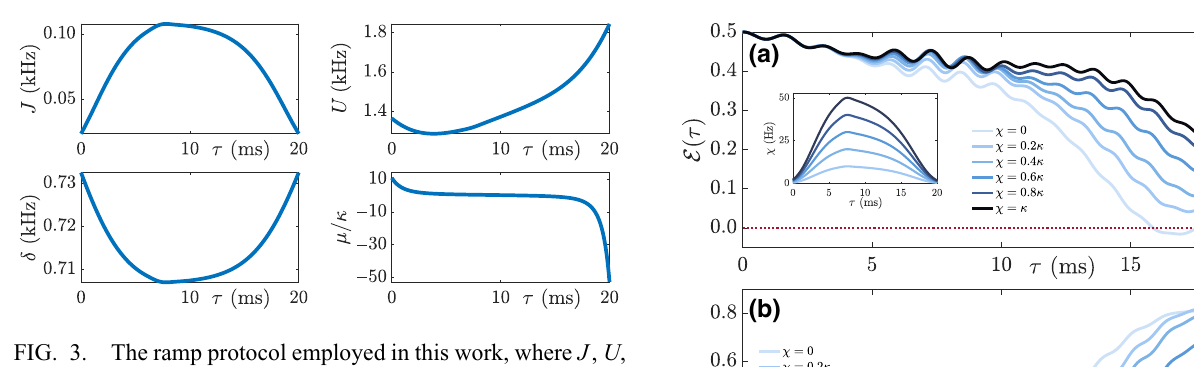
FIG. 3. The ramp protocol employed in this work, where J , U , and δ of Eq. (5) are tuned in such a way that the mass μ/κ of Eq. (3) is adiabatically ramped from a large positive value (where the ground state is one of two doubly degenerate Z 2 symmetry- broken vacua in the deconfined regime) to a large negative value (where the ground state is the charge-proliferated state in the deconfined regime). Here, the total ramp time τ = 20 ms is much smaller than the coherence time of the experimental setup in Ref.